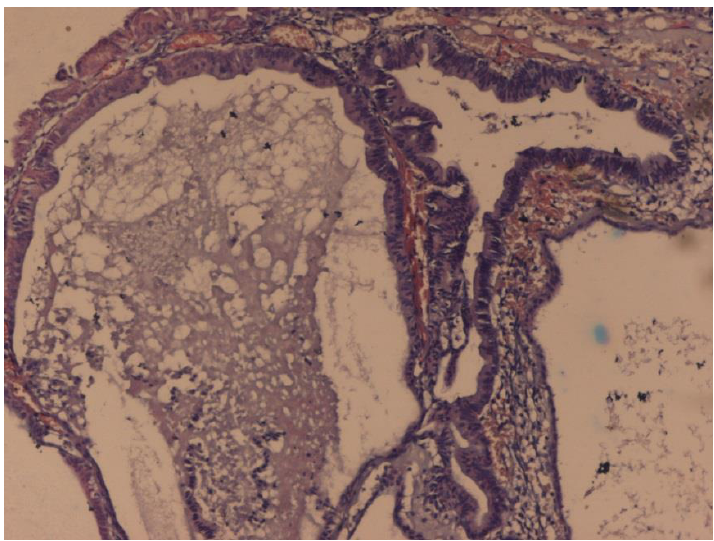
Figure 3. The typical blue-coloured mucin in the stroma between the tubules and the cords. Alcian blue stain, 40×.